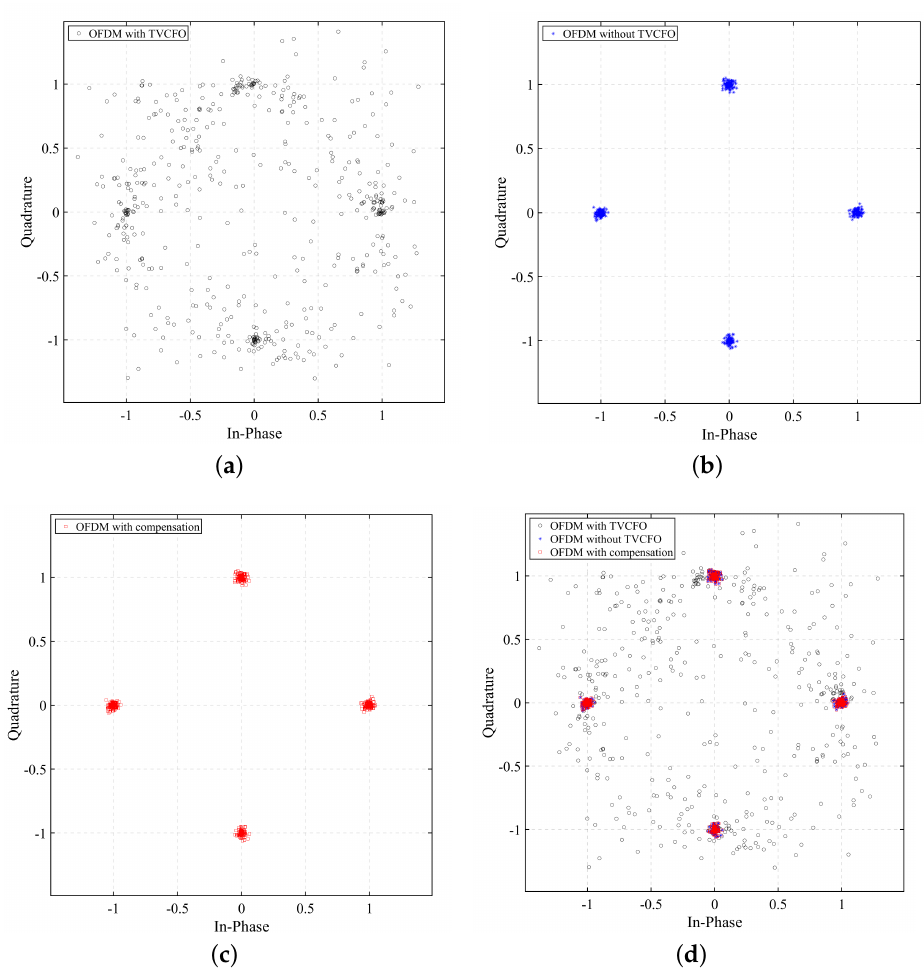
Figure 7. Constellations of demodulations in three cases: ( a ) without CFO compensation, ( b ) with actual CFO compensation, ( c ) with DE estimation values compensation and ( d ) comparison of the